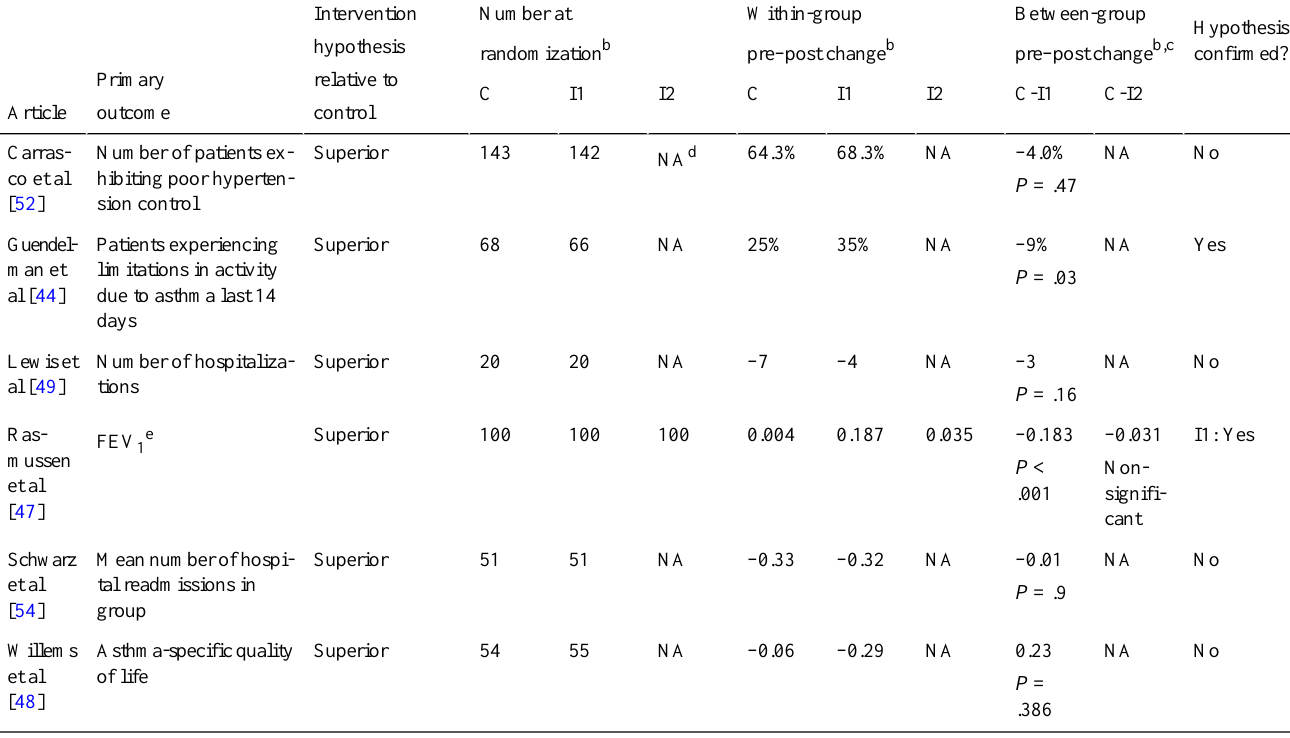
Table 3. Effects reported in monitoring with clinical support randomized controlled trials of acceptable quality of electronic symptom reporting,